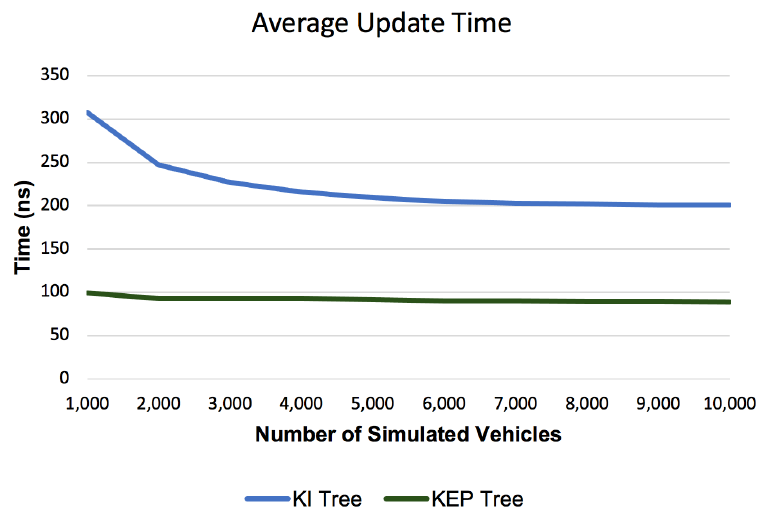
Figure 17. Average Update Time for KI and KEP Trees.